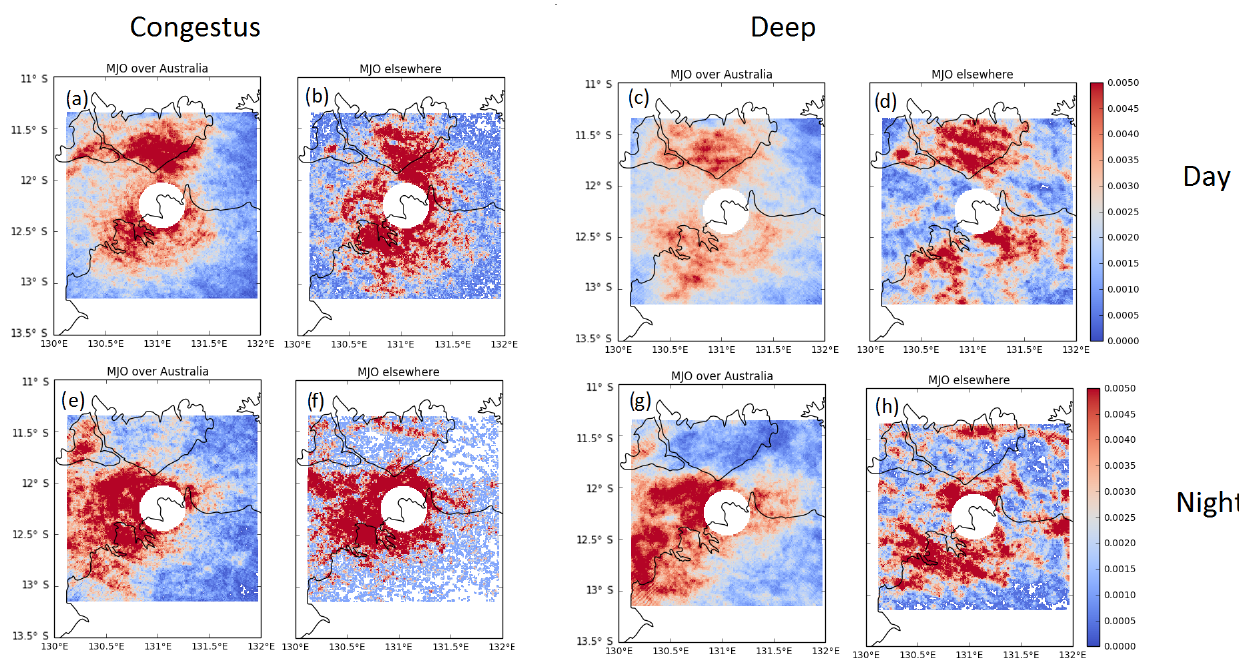
Figure 11. As in Fig. 10, but for active monsoon